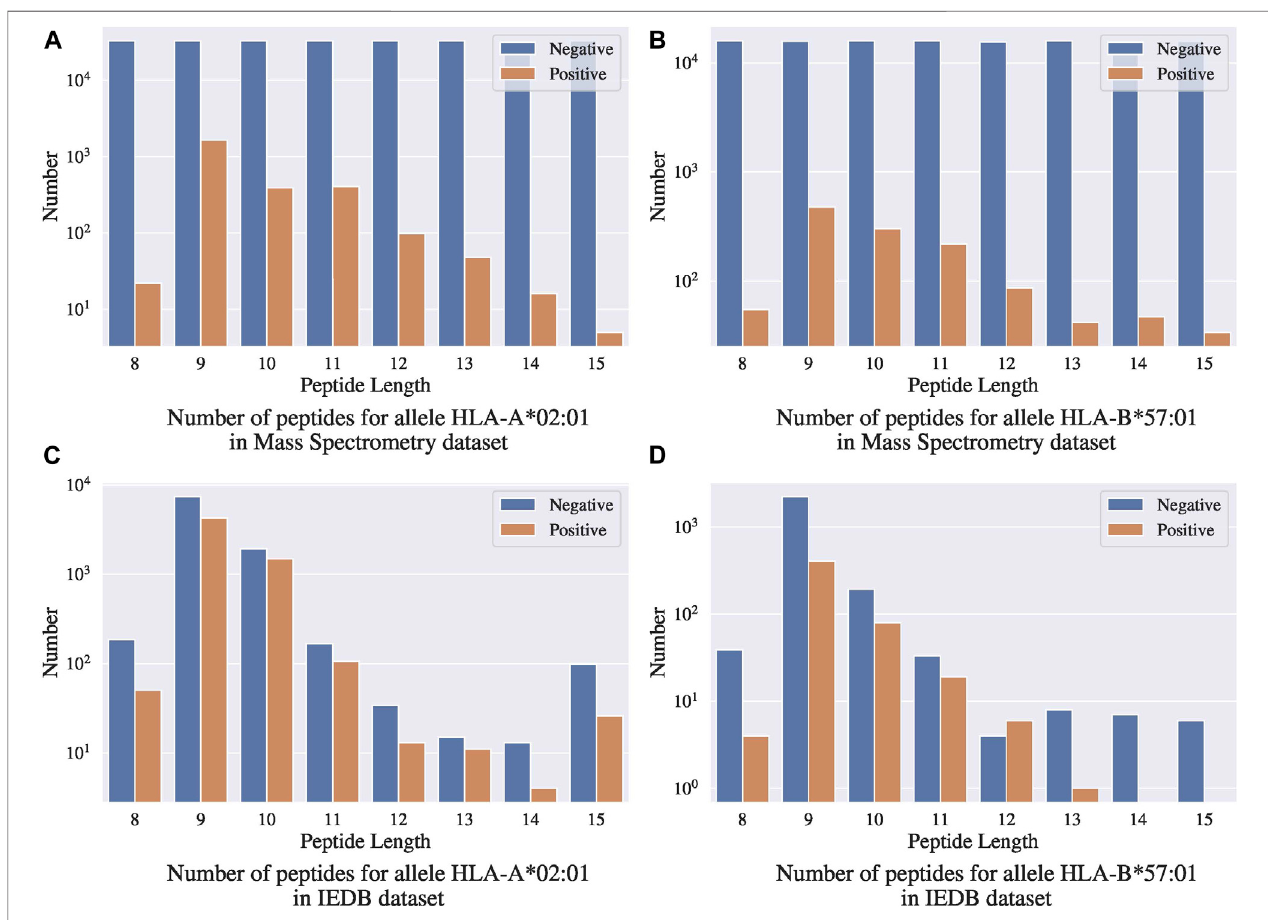
FIGURE 7 | Comparison between mass spectrometry dataset and IEDB dataset.